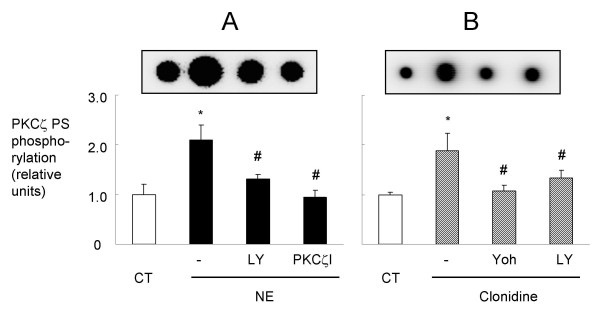
NE and clonidine activate PKCζ in canine mesenteric vein. Phosphorylation of a specific PKCζ peptide substrate (PKCζPS) in vitro by total protein extracts obtained from untreated controls (CT) and tissues incubates for 3 min with 1 μM NE (A) or 1 μM clonidine (B), without or after 60-min preincubation with LY-294002 (10 μM), myristoylated PKCζ peptide inhibitor (PKCζI, 50 μM) or yohimbine (Yoh, 0.1 μM). Phosphorylation of the PKCζ PS (i.e. density of the phospho-PS dots) was quantitated by radiography and densitometry (insets). Phosphorylation of PKCζSP in treated tissues is presented relative to non-treated tissue controls (bar graph, n = 3). *, P < 0.05 versus control; #, P < 0.05 versus veins treated with NE or clonidine.